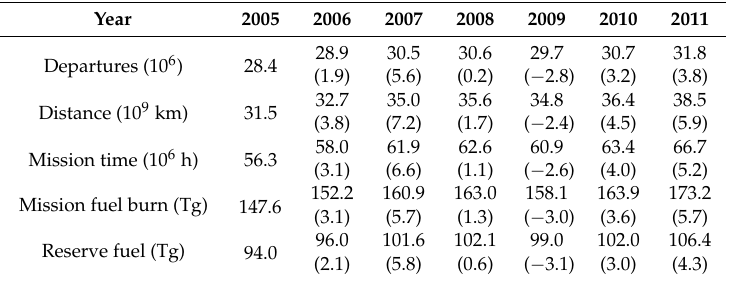
Table 1. Global totals and percent changes of the number of departures, mission distance and time, total fuel, mission fuel, and reserve fuel during